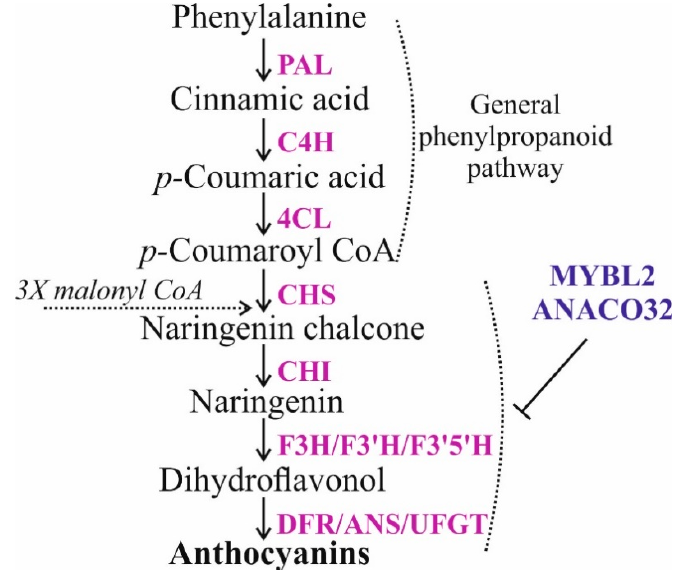
Figure 1. Schematic representation of the anthocyanin biosynthesis pathway. Enzymes of each step are shown in purple. Enzymes involved in general phenylpropanoid pathway are phenylalanine ammonia lyase (PAL), cinnamate 4-hydroxylase (C4H) and 4-coumaryol CoA ligase (4CL). Enzymes involved in flavonoid biosynthesis are chalcone synthase (CHS), chalcone isomerase (CHI), flavanone 3-hydroxylase (F3H), flavanone 3 ′ 5 ′ -hydroxylase, (F3 ′ 5 ′ H) and flavanone 3 ′ -hydroxylase (F3 ′ H). Anthocyanins are synthesized by dihydroflavonol 4-reductase (DFR), synthase (ANS), and UDP-glucose:flavonoid-3-O-glucosyltransferase (UFGT). Two transcriptional factors negatively regulating anthocyanin biosynthesis include a R3-type single-MYB protein (MYBL2) and a NAC-type transcription factor (ANAC032).